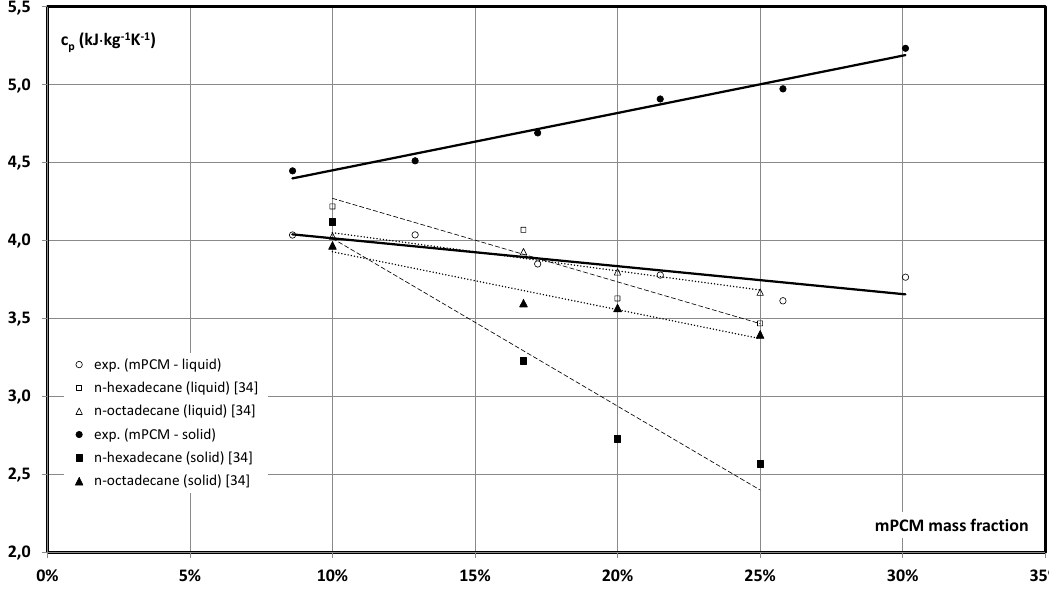
Figure 4. Influence of PCM mass fraction on specific heat of mPCM slurry.